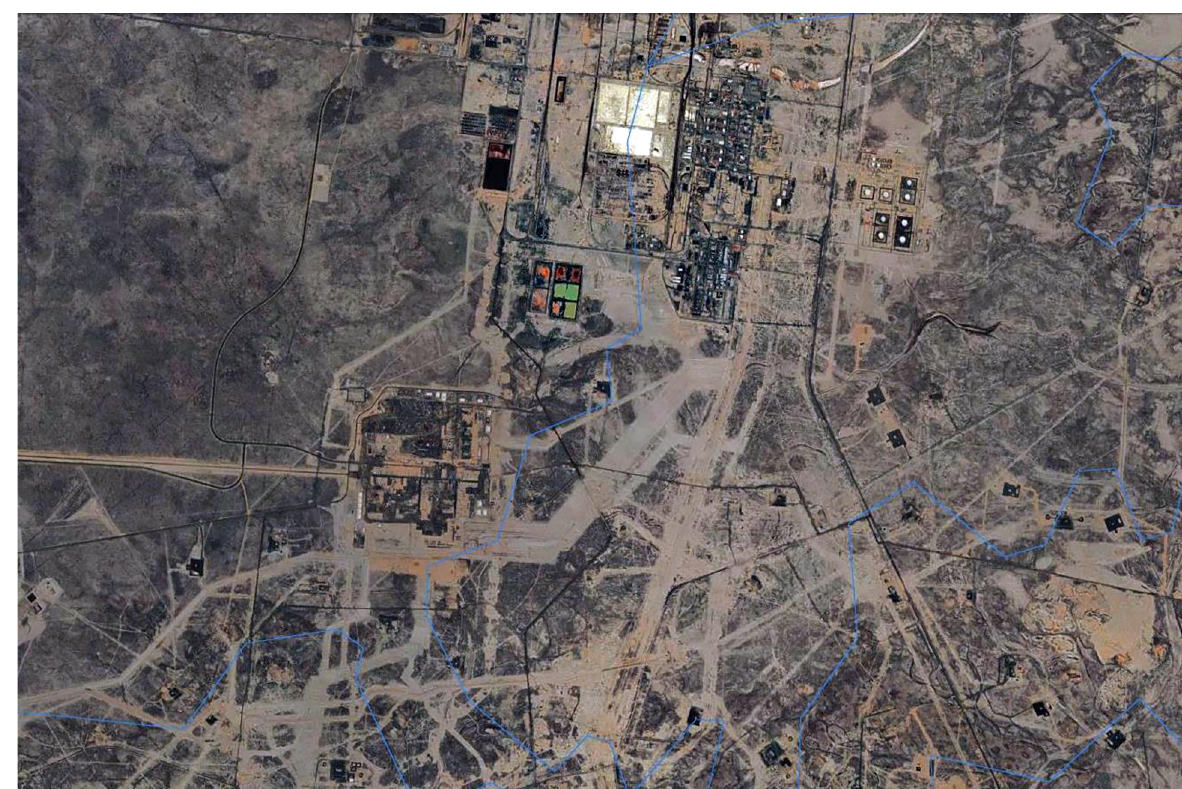
Fig. 4. The infrastructure of the Tengiz oil